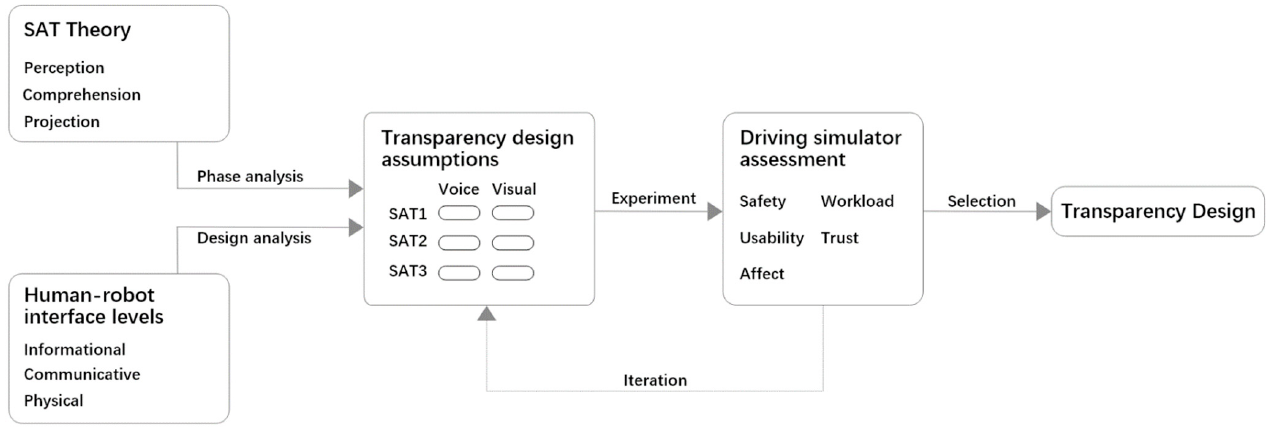
Figure 1. Research framework.